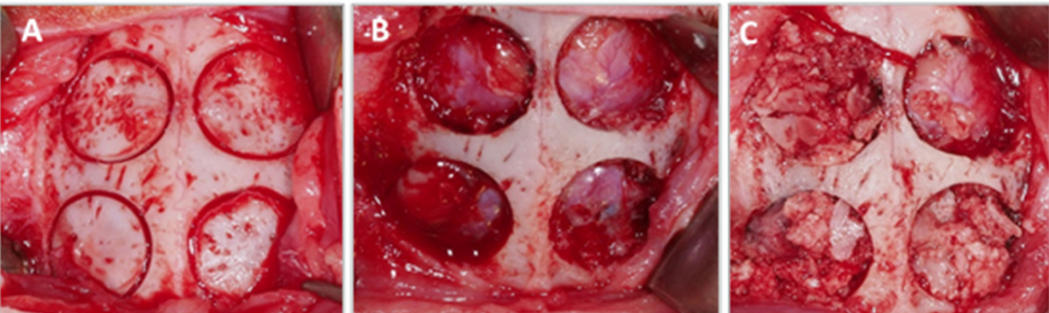
Figure 2. Summary of the surgical procedure followed in the study undertaken. ( A ) Bone defects made with trephine. ( B ) Removal of the tablet bone exposing the dura mater. ( C ) Filling of the defects (upper left PSB; upper right Control group; bottom left SB group and bottom right PS